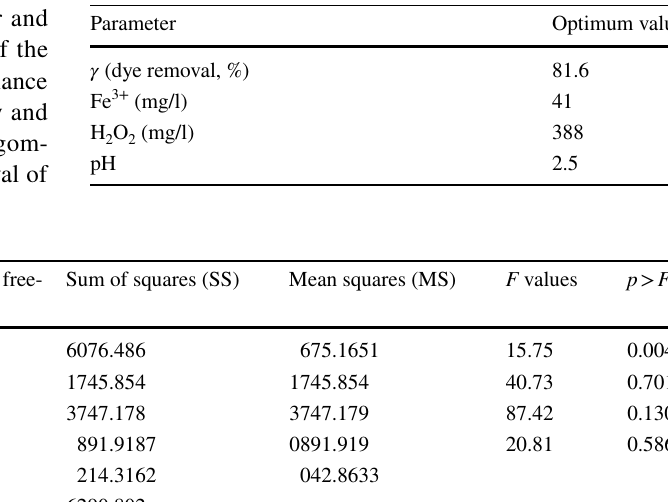
R 2 , coefficient of determination, values were 0.97 for dye percent